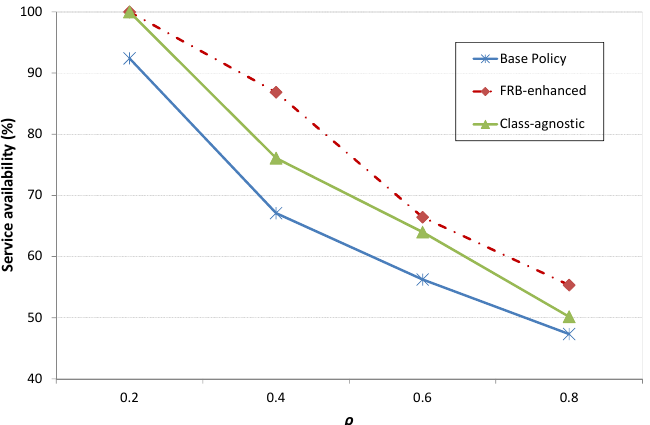
Figure 13. Overall service availability plot for the three scenarios.